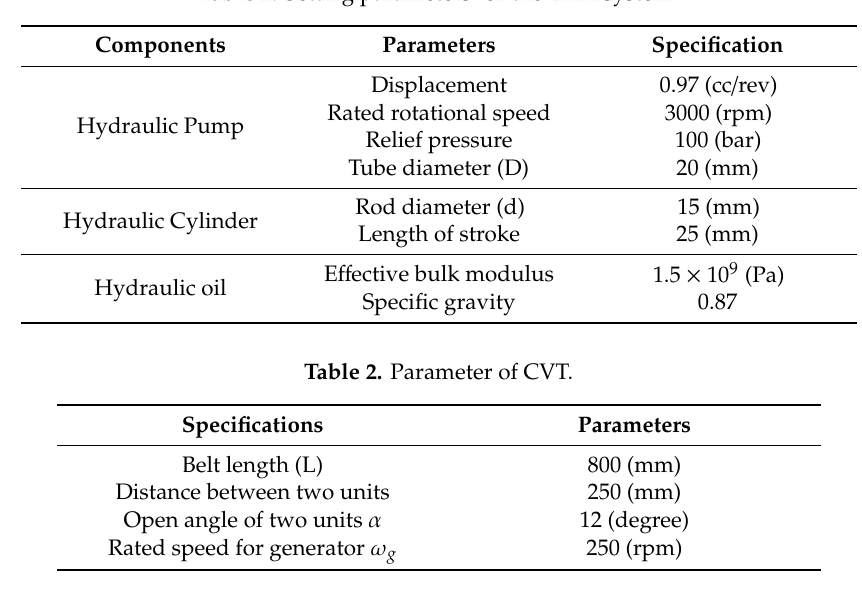
Table 1. Setting parameters for the EHA system.